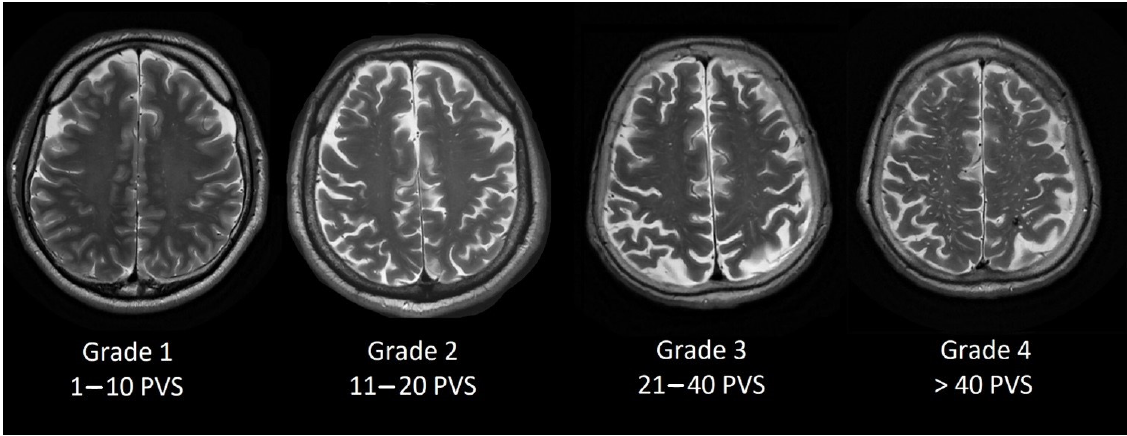
Figure 2. Dilated PVS in centrum semiovale from Grade 1 to Grade 4.